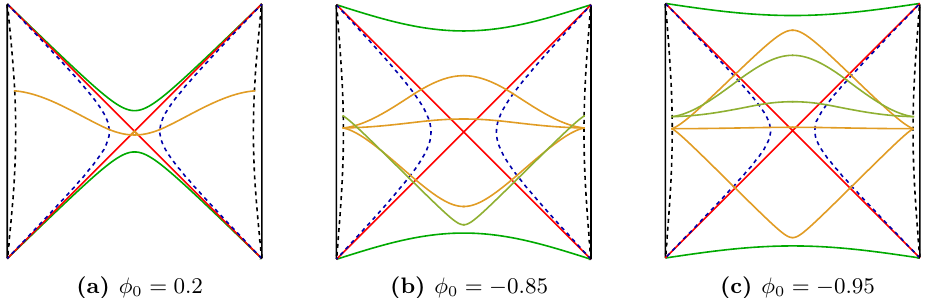
Figure 8. Penrose diagrams for the different γ -centaur geometries and geodesics anchored at different boundary times. The dashed black line is the cutoff surface with R b = 10 . The dark blue dashed line is the interpolating line at r = φ 0 , the red lines are the horizons and the green ones are r → −∞ . Yellow lines correspond to geodesics at early times and green lines to geodesics at slightly later times.